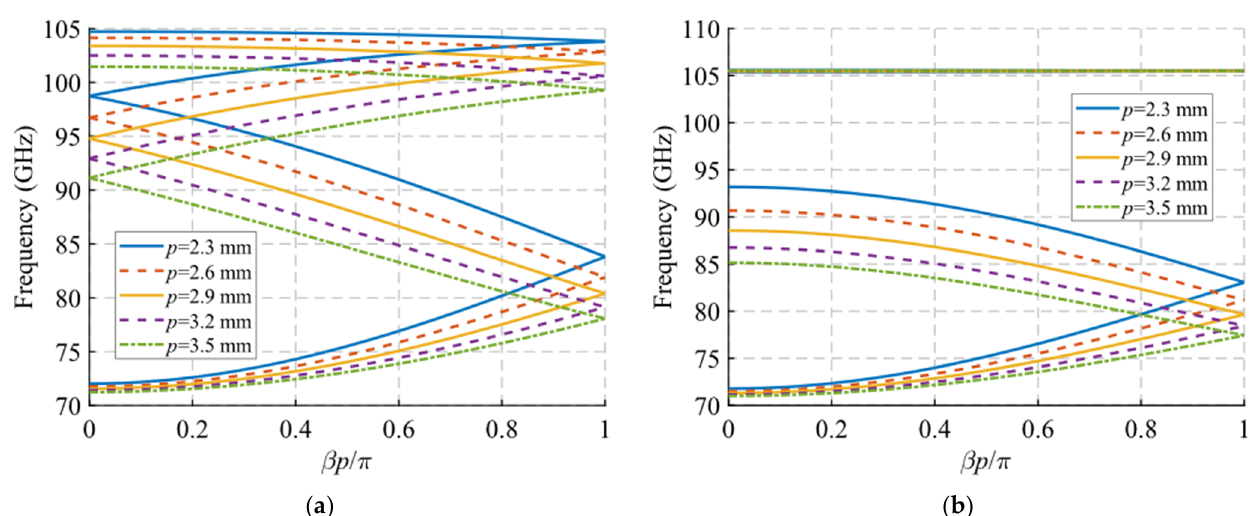
Figure 10. Dispersion diagram of the double-periodic unit cell for various values of p . ( a ) Glide- symmetric configuration ( d = 0.725 mm) and ( b ) maximum rupture of symmetry configuration ( d = 0 mm).